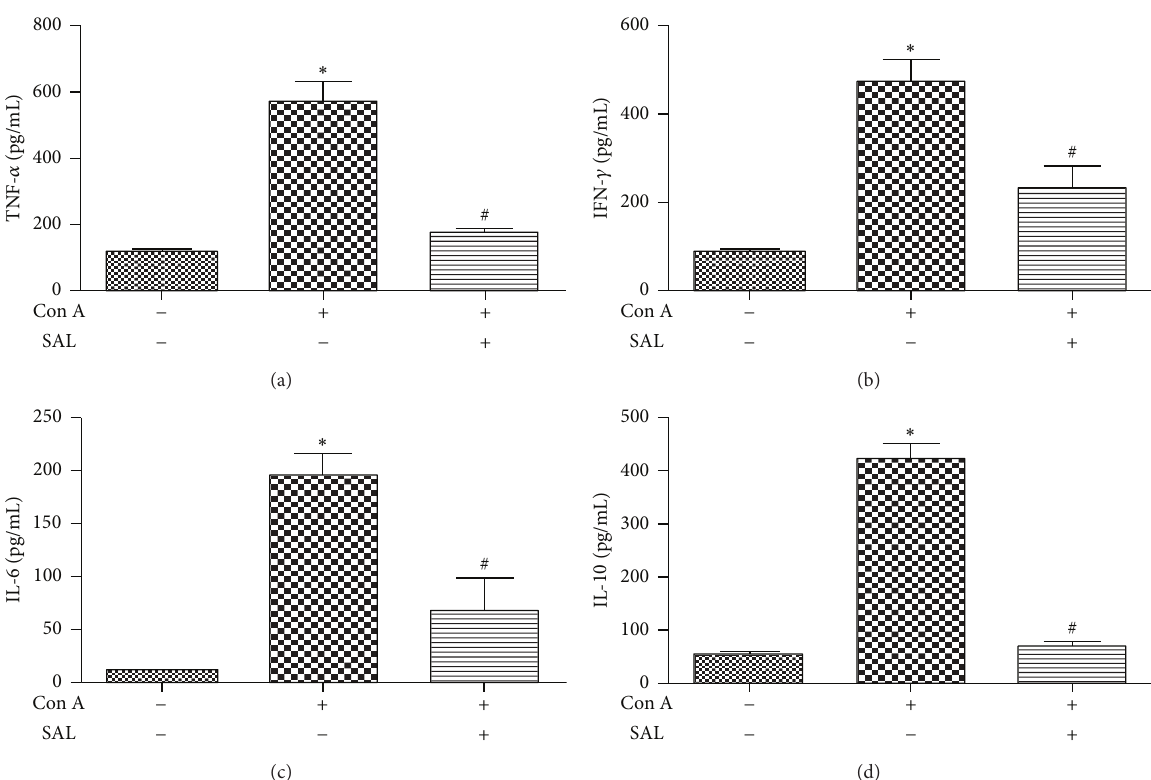
Figure 3: The effect of salidroside on cytokine production in Con A-treated mice. Samples were collected 12h after Con A administration. (a)–(d) Salidroside reduced plasma proinflammatory cytokine secretion. ∗ 𝑃 < 0.01 versus control group, # 𝑃 < 0.01 versus Con A group.